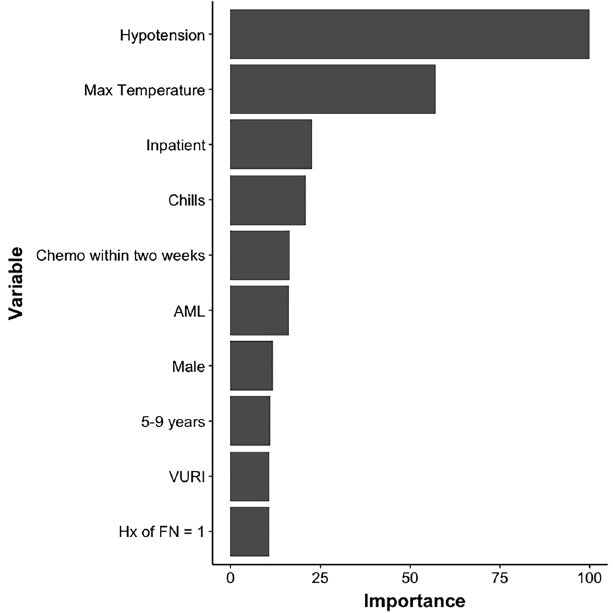
Figure 3. Depicts a list of variables important to the prediction of PICU admission with resampling of the multivariate analysis. The maximum temperature and hypotension recorded at time of presentation of FN episode were the most important variables for predicting transfer to